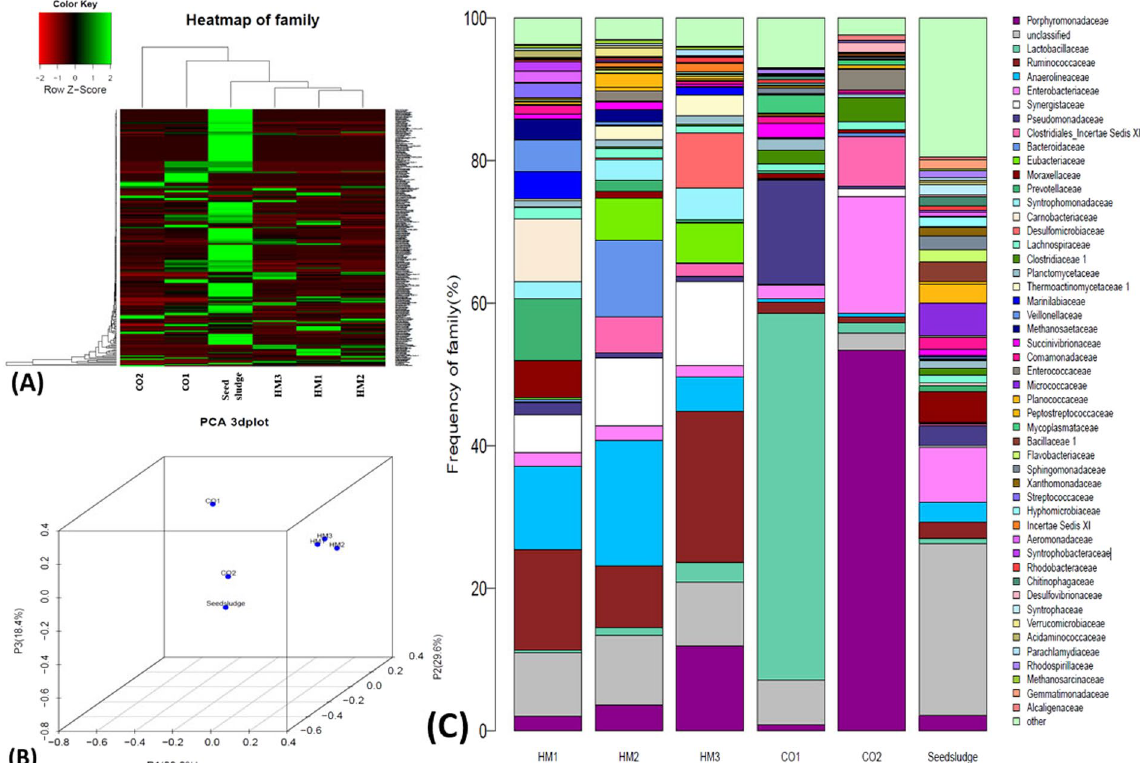
Figure 4. ( A ) Hierarchical cluster analysis of bacterial communities in the sludge samples of high-solids hydrolytic stage (CO1) of HM3, high-solids acidogenic stage (CO2) of HM3, HM1, HM2, HM3 and seed sludge. The OTUs were instructed at family level. Sample communities were clustered according to the method of complete linkage. The colour intensity of scale indicates relative abundance of each OTU read. Relative abundance was defined as the numbers of sequences affiliated with that OTU divided by the total number of sequences per sample. ( B ) 3D-plot of principal component analysis (PCA) analysis of bacterial communities. ( C ) Taxonomic classification of the dominant phylogenetic groups from high-solids hydrolytic stage (CO1) of HM3, high-solids acidogenic stage (CO2) of HM3, HM1, HM2, HM3 and seed sludge at the family